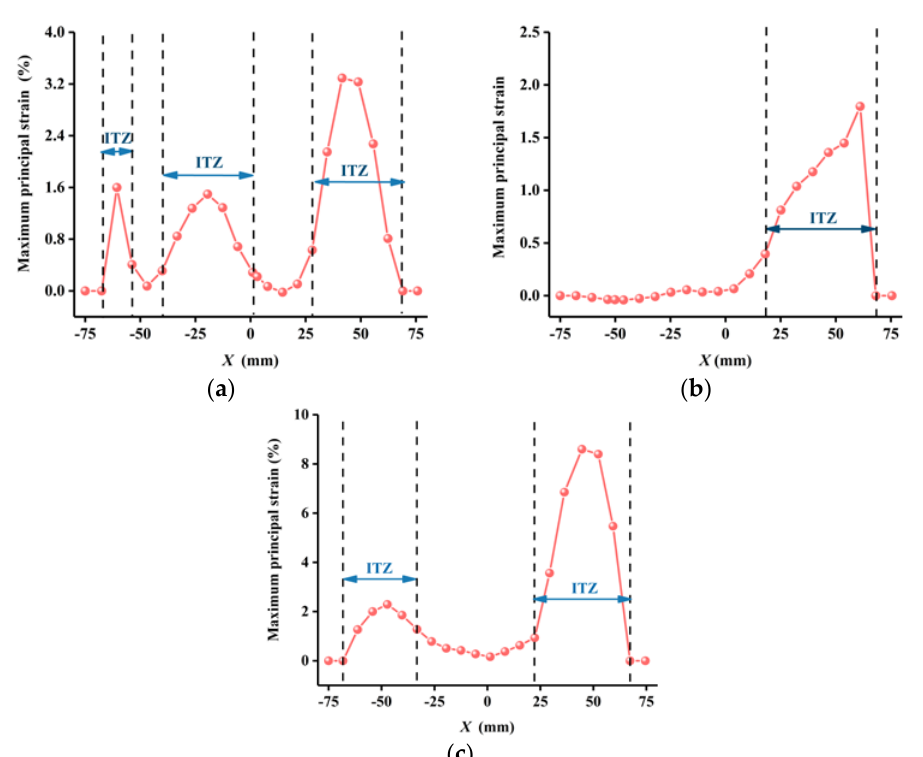
Figure 7. Maximum principal strain on the horizontal section. ( a ) SRB-1. ( b ) SRG-1. ( c ) SRL-1 .